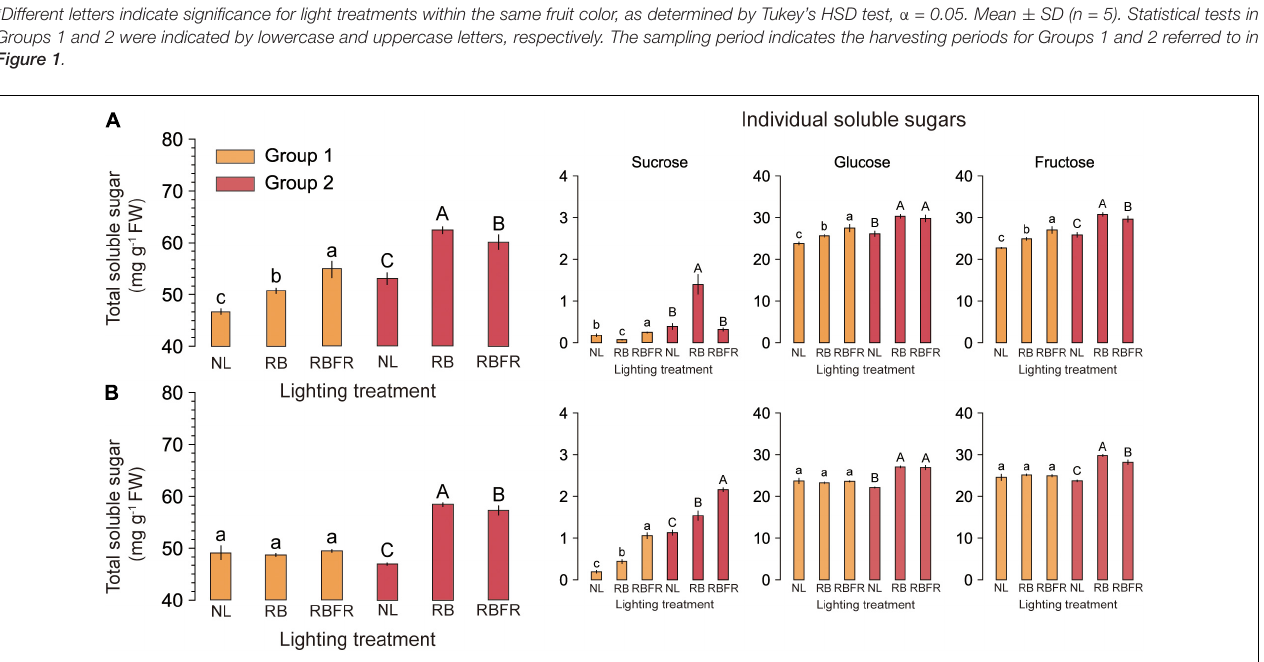
Ascorbic acid LB/Newton) content (mg/g FW)